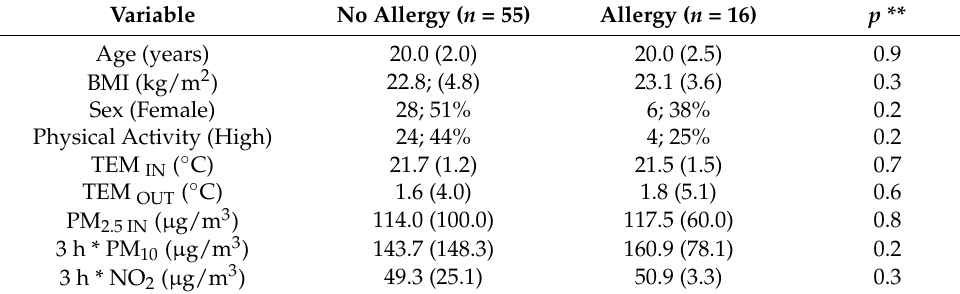
Table 4. Basic comparison of no-allergy ( n = 55) and allergy ( n = 16) groups. Variable